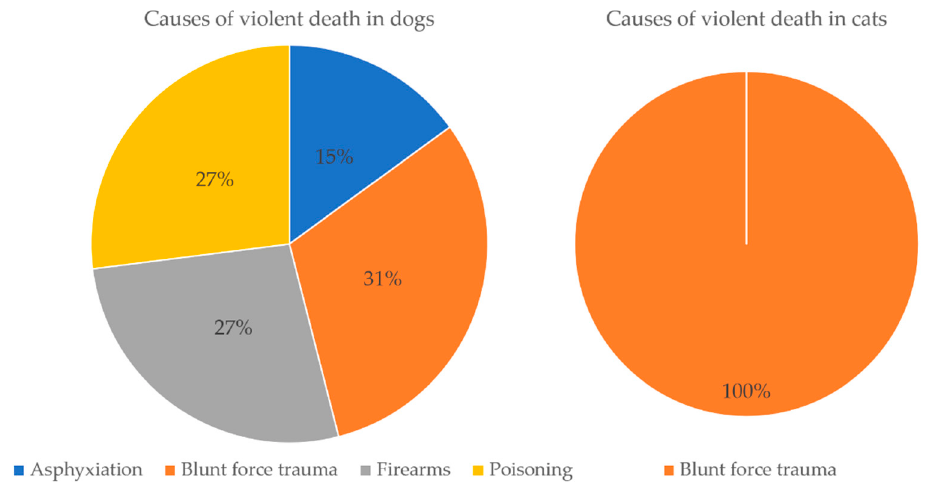
Figure 1. Graph representing the causes of violent death in dogs ( n = 33) and cats ( n = 5) in the period under study.